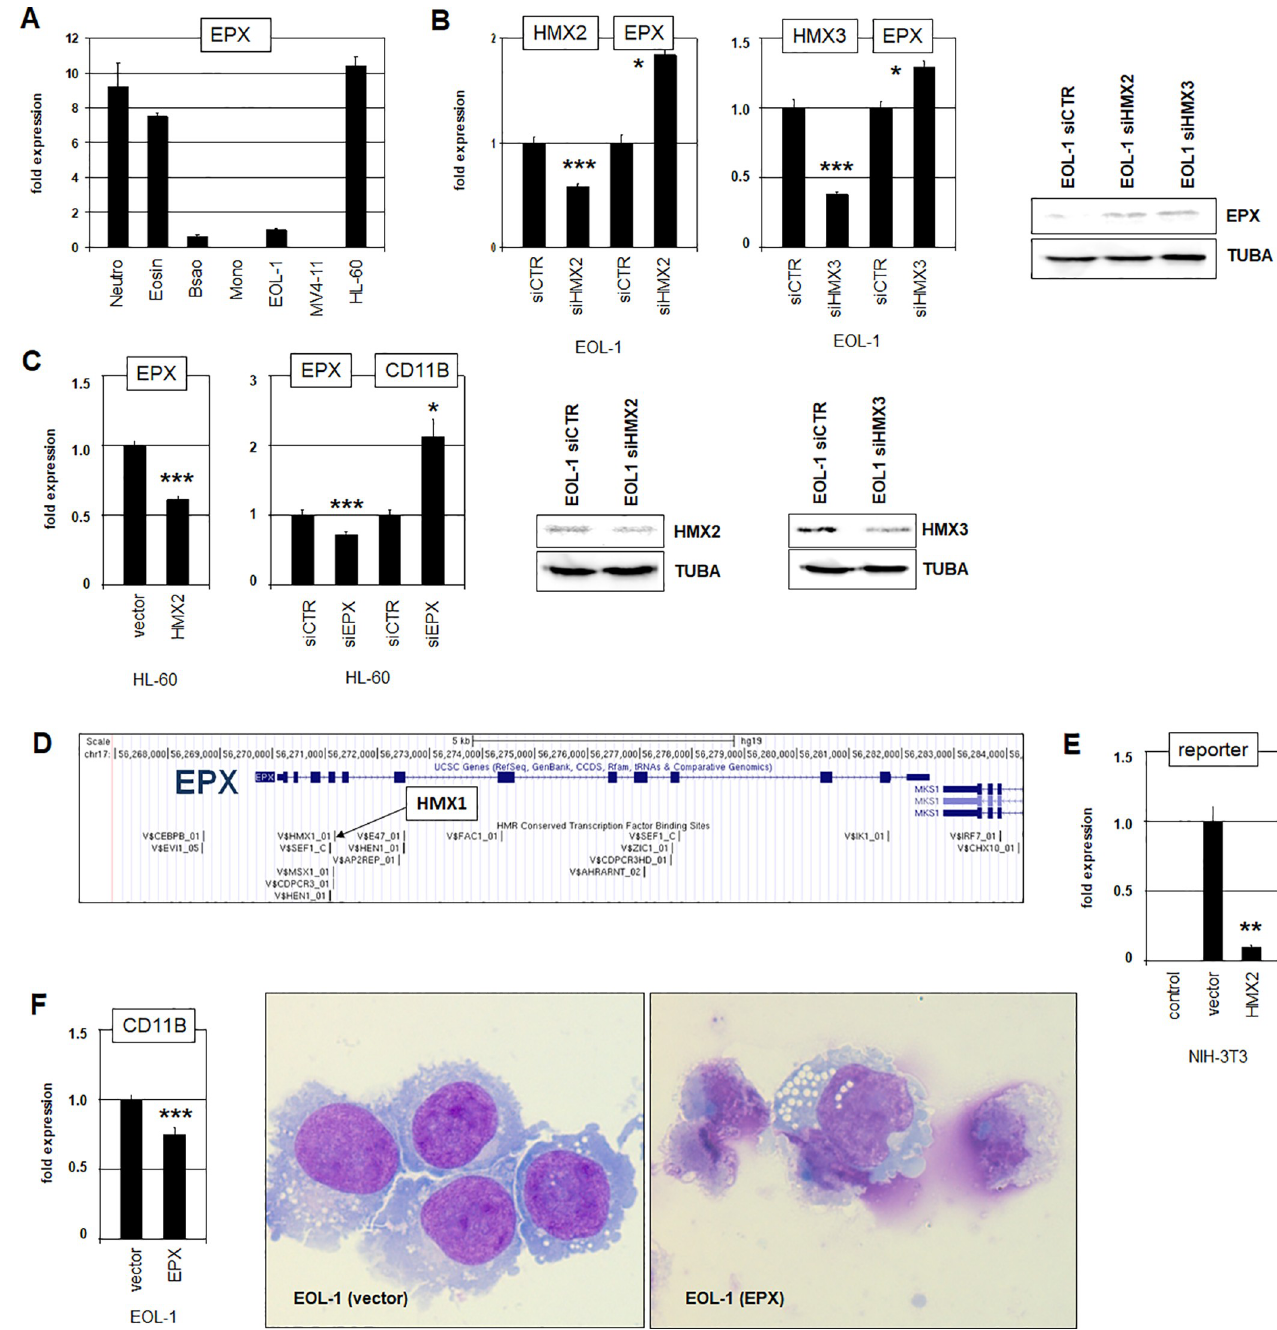
Fig 6. Regulation of EPX by HMX2 and HMX3. (A) Quantification of EPX expression in primary granulocytes (neutrophils, eosinophils, basophils) and selected cell lines by RQ-PCR. (B) SiRNA-mediated knockdown of HMX2 (left) and HMX3 (right) resulted in elevated expression levels of EPX. Reduced expression of HMX2 and HMX3 and elevated expression of EPX was also shown by Western blot analysis. Asterisks indicate calculated p-values obtained by t- Test analysis of controls (siCTR) and siRNA-targeted knockdown. (C) Forced expression of HMX2 in HL-60 cells resulted in reduced expression level of EPX (left). SiRNA-mediated knockdown of EPX resulted in activation of CD11B expression (right). (D) A genomic map of the locus for EPX was obtained from the UCSC genome browser, showing potential transcription factor binding sites including one for HMX1. (E) Reporter-gene assay in NIH-3T3 cells using a fragment containing the identified HMX-site. Forced expression of HMX2 resulted in decreased reporter-gene activity, demonstrating a direct repressive impact. (F) Forced expression of EPX in EOL-1 slightly reduced the expression level of CD11B. Microscopical inspection of Giemsa-May-Gru¨nwald-stained EOL-1 cells indicated strongly induced apoptosis by forced EPX expression as possible consequence of continued differentiation. Living cells resemble differentiated cells after DMSO-induction.